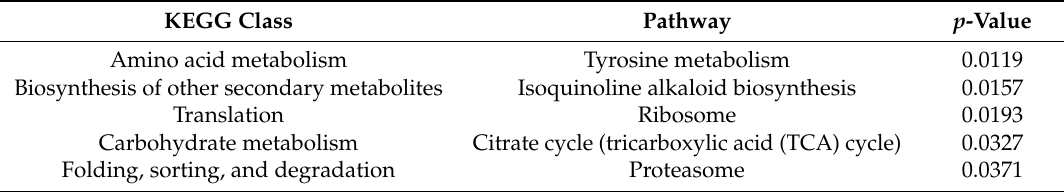
Table 6. KEGG terms enriched among upregulated DEGs specific to the TS vs. TP